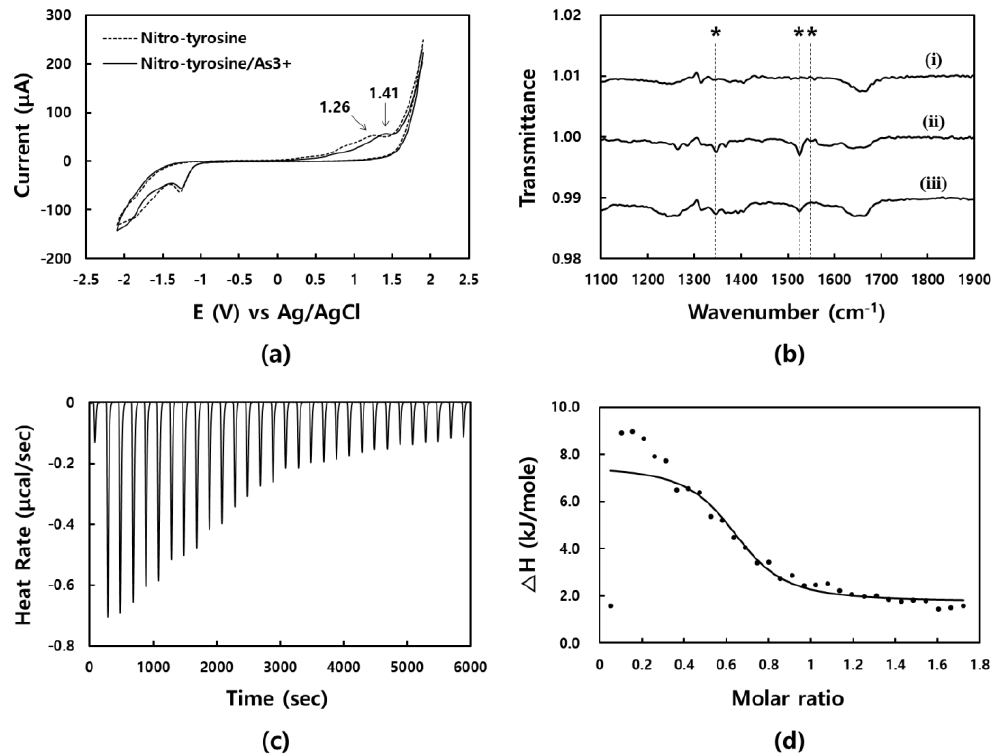
Figure 3. ( a ) Cyclic voltammograms of N-Tyr (dotted line) and the mixture (solid line) of N-Tyr and As 3+ : The oxidation peak is shifted from 1.26 to 1.41 V in the presence of As 3+ . ( b ) IR spectra of (i) As 3+ , (ii) N-Tyr, and (iii) As 3+ /N-Tyr. The asterisks indicate the stretching modes associated with the NO 2 group of N-Tyr. ( c ) Isothermal titration calorimetry (ITC) graph. Heat rate along with reaction time is plotted. ( d ) The normalized fit curve of △ H depending on molar ratio of the As 3+ /N-Tyr mixture is displayed.